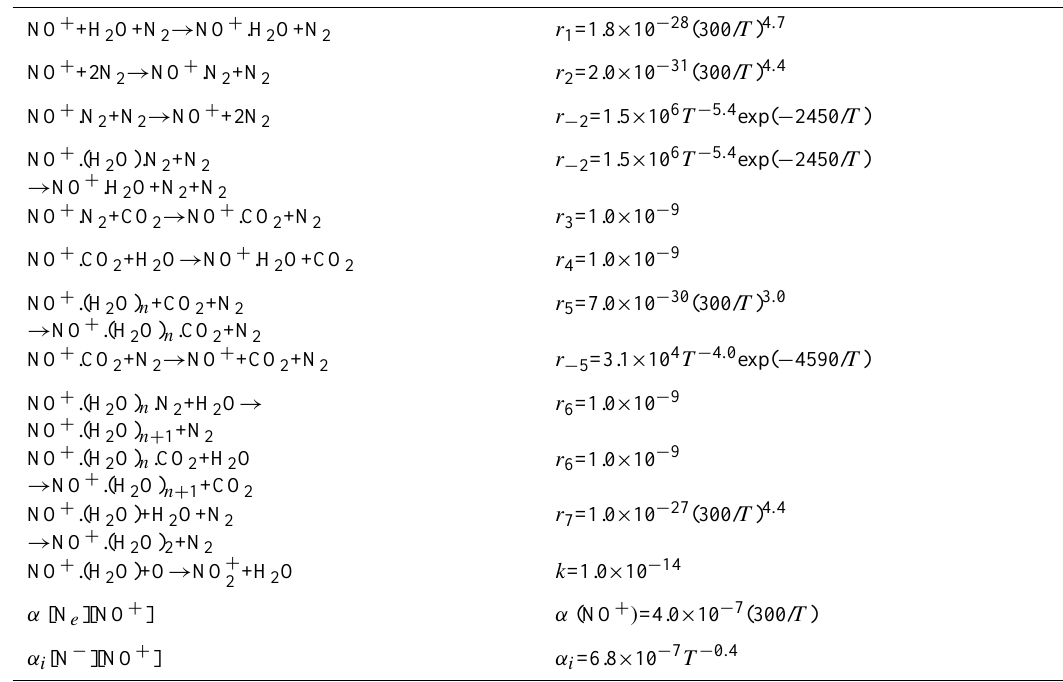
Table A1. Rate constants for positive ion reactions in the reaction path NO + → CB + α i (NO + ) .